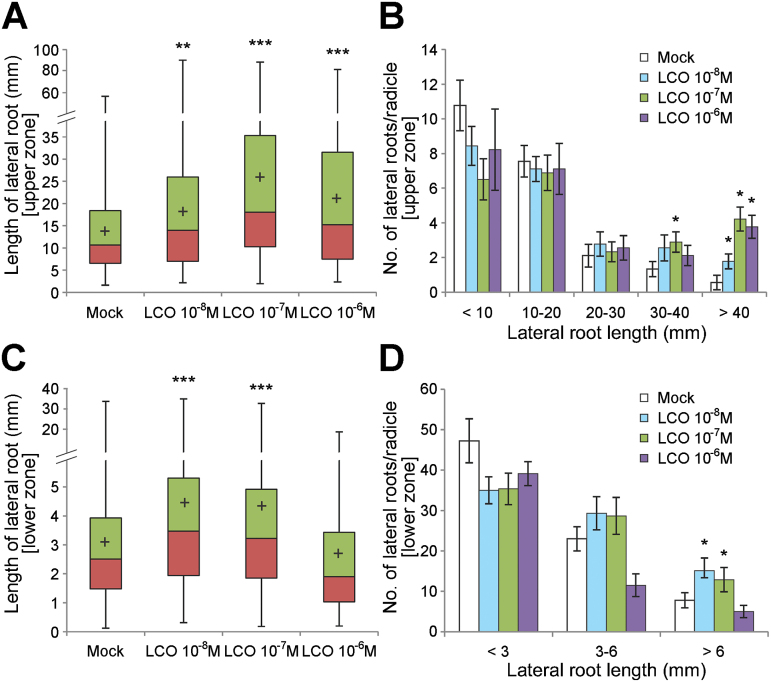
Effects of LCO on lateral root growth of maize seedlings. (A-D) Lateral roots in upper zone in A and B, and lower zone, newly elongated zone in C and D, of radicle were observed separately (see the cartoon in Supplementary Fig. S1 for details). Three-day-old seedlings were grown for 7 d in LCO-containing liquid medium in growth pouches. The box plot in A and C shows with mean value ‘+’ (n = 9), and the median, 25th, and 75th percentiles are marked with line segments across the box. The histogram in B and D shows the distribution of lateral root lengths. Asterisks represent statistically significant differences compared with the control (*P<0.05, **0.001<P<0.01, ***P<0.001).